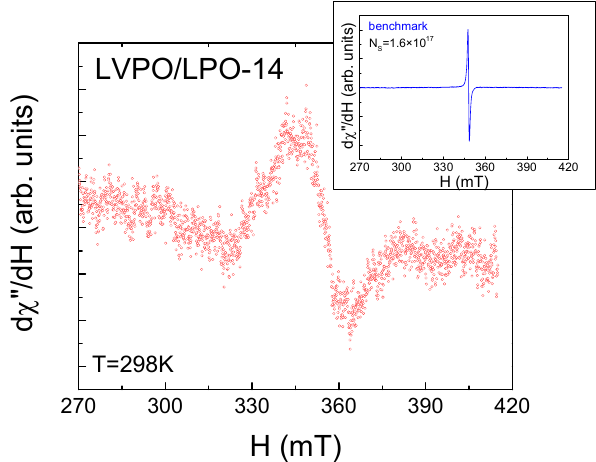
Figure 4. SEM images of the Li 3 V 2 (PO 4 ) 3 (92.5 wt%)/Li 3 PO 4 (7.5 wt%) composite surfaces after multiple charge/discharge cycles at different magnifications: ( a ) delithiated sample ( b ) relithiated sample.